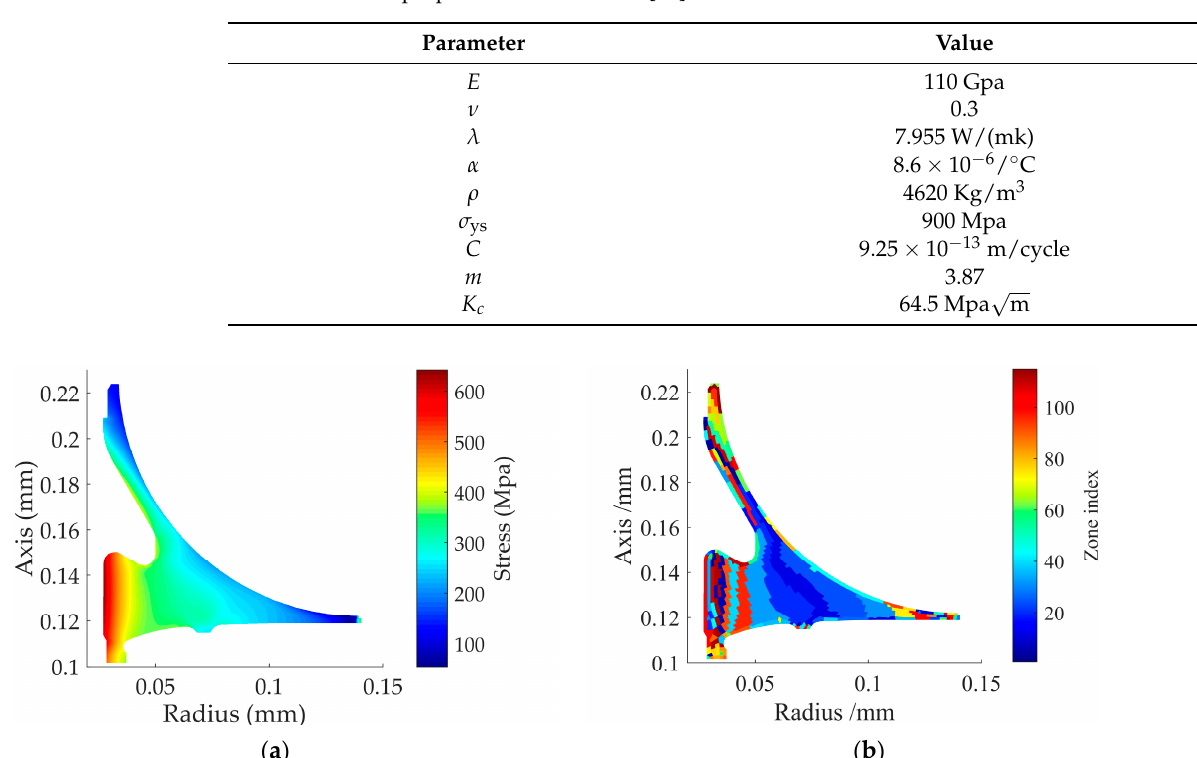
Table 2. Material properties of Ti-6AL-4 V [23].